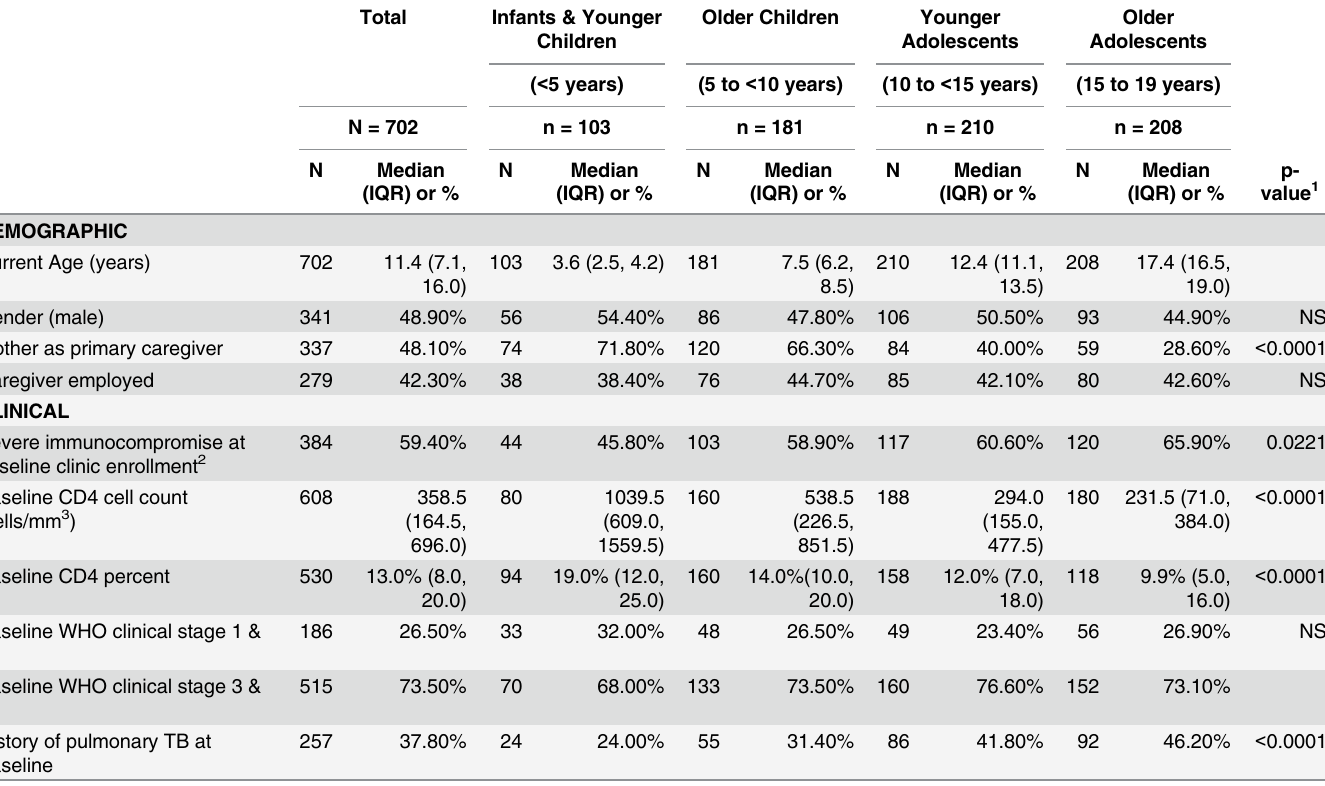
Table 1. Demographic and baseline clinical characteristics of children and adolescents receiving HIV care in a public HIV program in Zimbabwe, by age at cross-sectional evaluation. Total Infants & Younger Older Children Younger Children